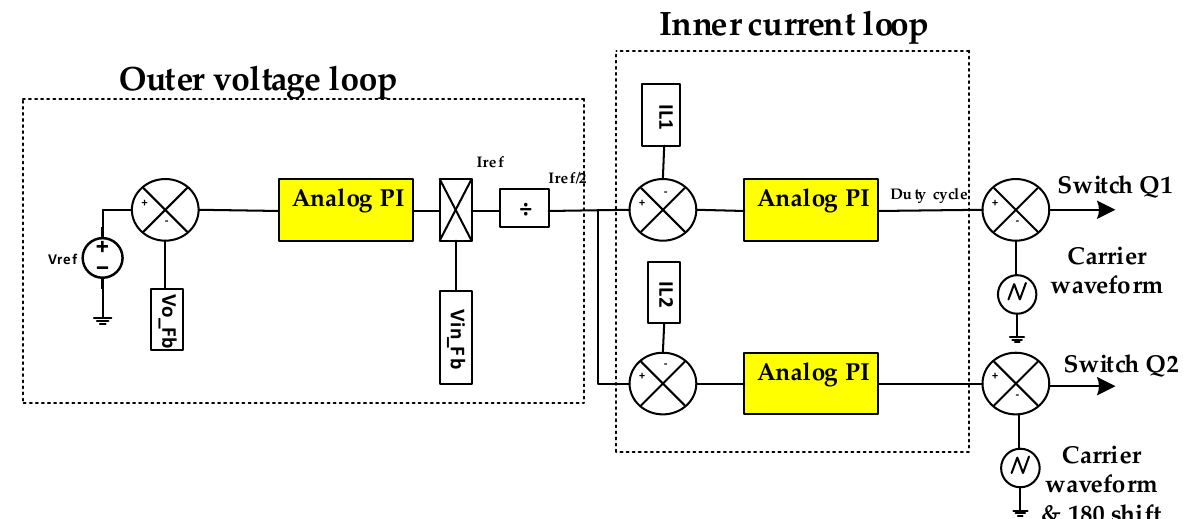
Figure 11. Implementation technique of the interleaved CCM PFC analog control circuit.